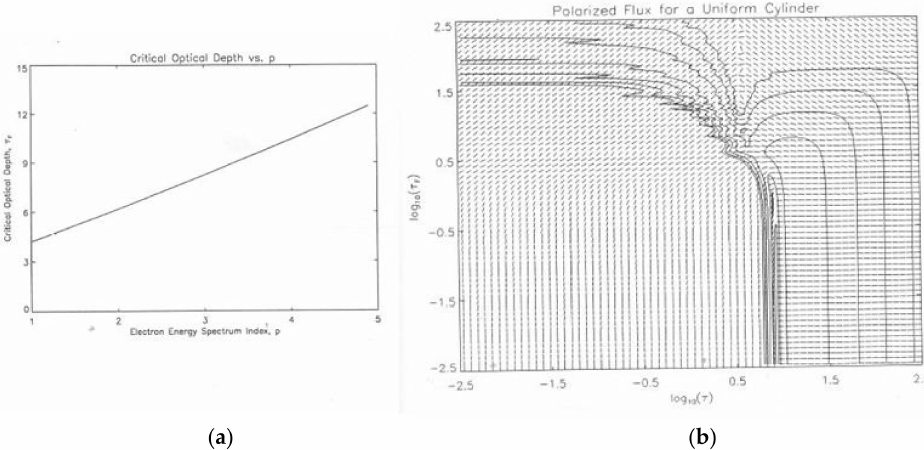
Figure 1. ( a ) The critical optical depth, τ , at which the EVPA changes by 90 ◦ as a function of electron energy spectral index, p. ( b ) The fractional polarization (contours) and EVPA (constant length tick marks) as a function of optical depth, τ , and Faraday depth, τ F , integrated over a cylinder, for p = 2.5. The lower left portion of this diagram represents optically thin, Faraday-thin emission. The lower right portion shows Faraday-thin, optically thick emission. The 90 ◦ change in the EVPA is only plainly visible for optical depths >10. Note that, in the top portion of the diagram, increasing Faraday depth limits the EVPA rotation to 45 ◦ . Figure 1a,b are copied from [4].